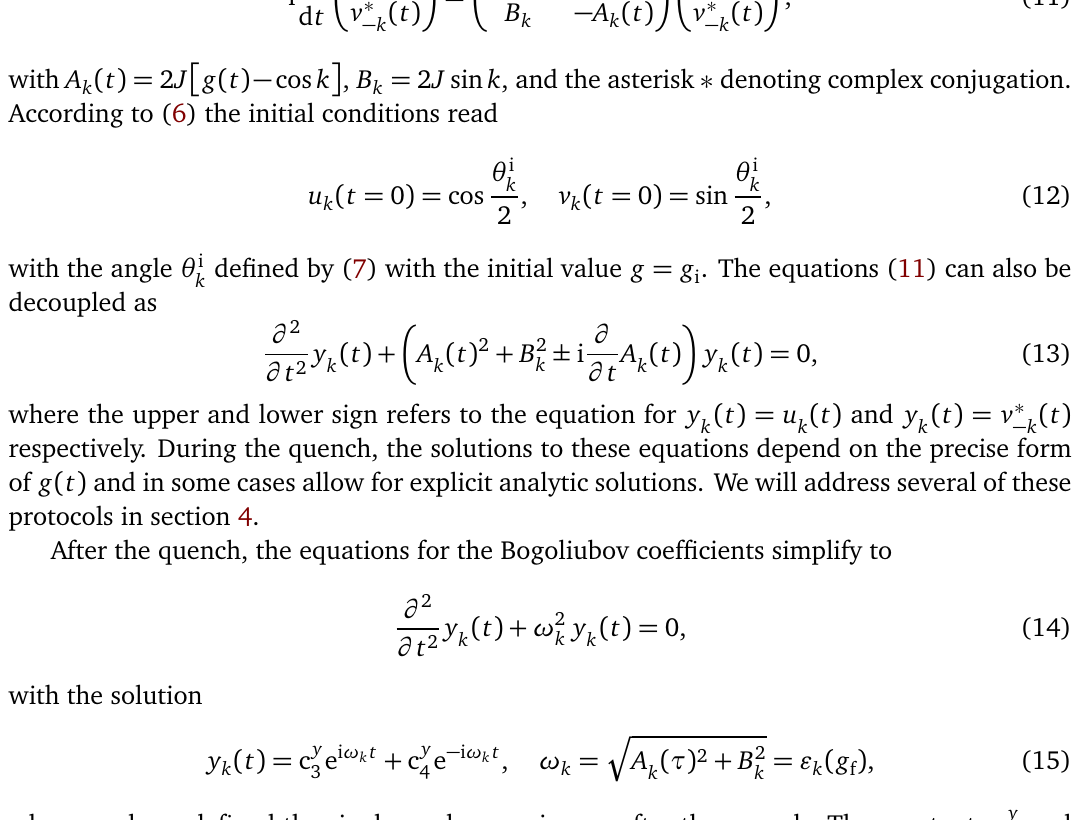
Figure 1: Left: Sketch of different quench protocols for g change rate of the